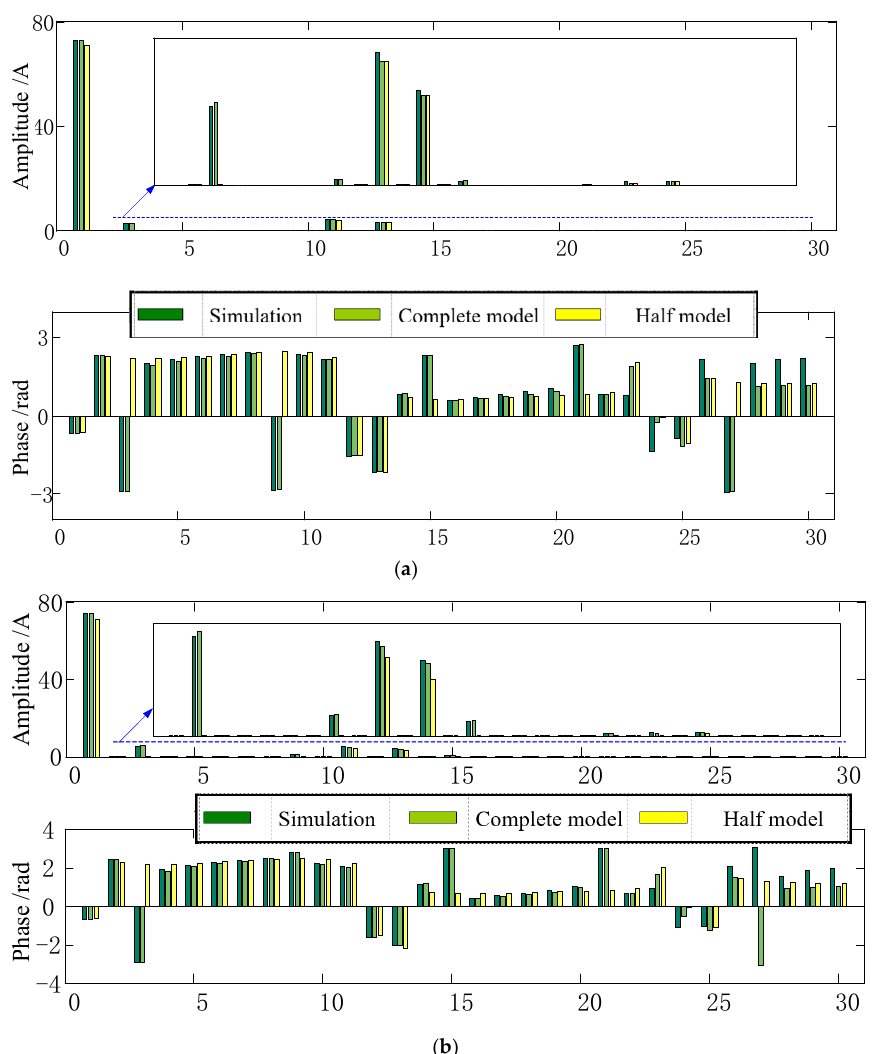
Figure 6. AC current harmonic spectrum of 12 ‐ pulse rectifier under different conditions. ( a ) Case 1; ( b ) Case 2.